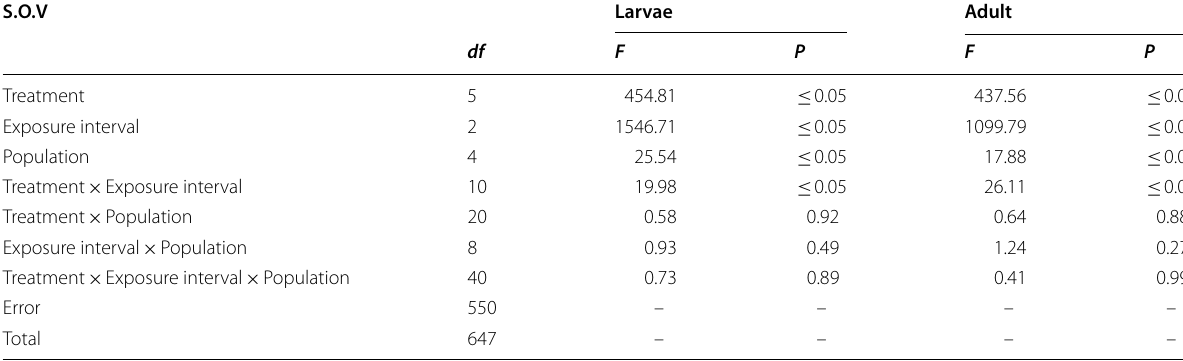
Table 1 ANOVA parameters for the main effects and associated interactions for mortality rates of Rhynchophorus ferrugineus larvae and adults